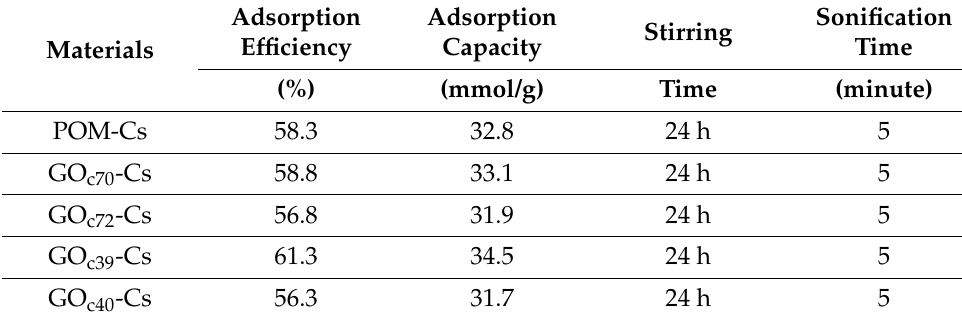
Table 2. Adsorption capacity, adsorption efficiency, and adsorption condition.